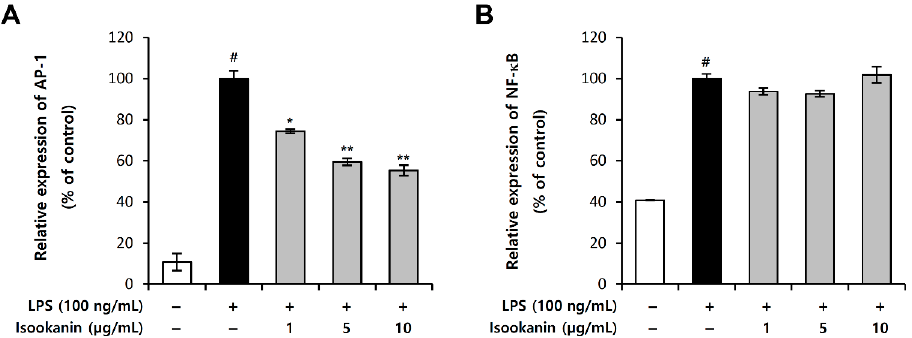
Figure 5. Effects of isookanin on activator protein 1 (AP-1) and nuclear factor κ B (NF- κ B) expression in LPS-induced RAW 264.7 cells. The ( A ) AP-1 and ( B ) NF- κ B luciferase reporter vector was transfected into RAW 264.7 cells and cultured for 24 h. The cells were pretreated with isookanin for 2 h and then stimulated with LPS (200 ng/mL). Luciferase activity was calculated against an LPS-unstimulated control. The results are mean ± standard deviation (SD) ( n = 3). # p < 0.01 vs. LPS-untreated